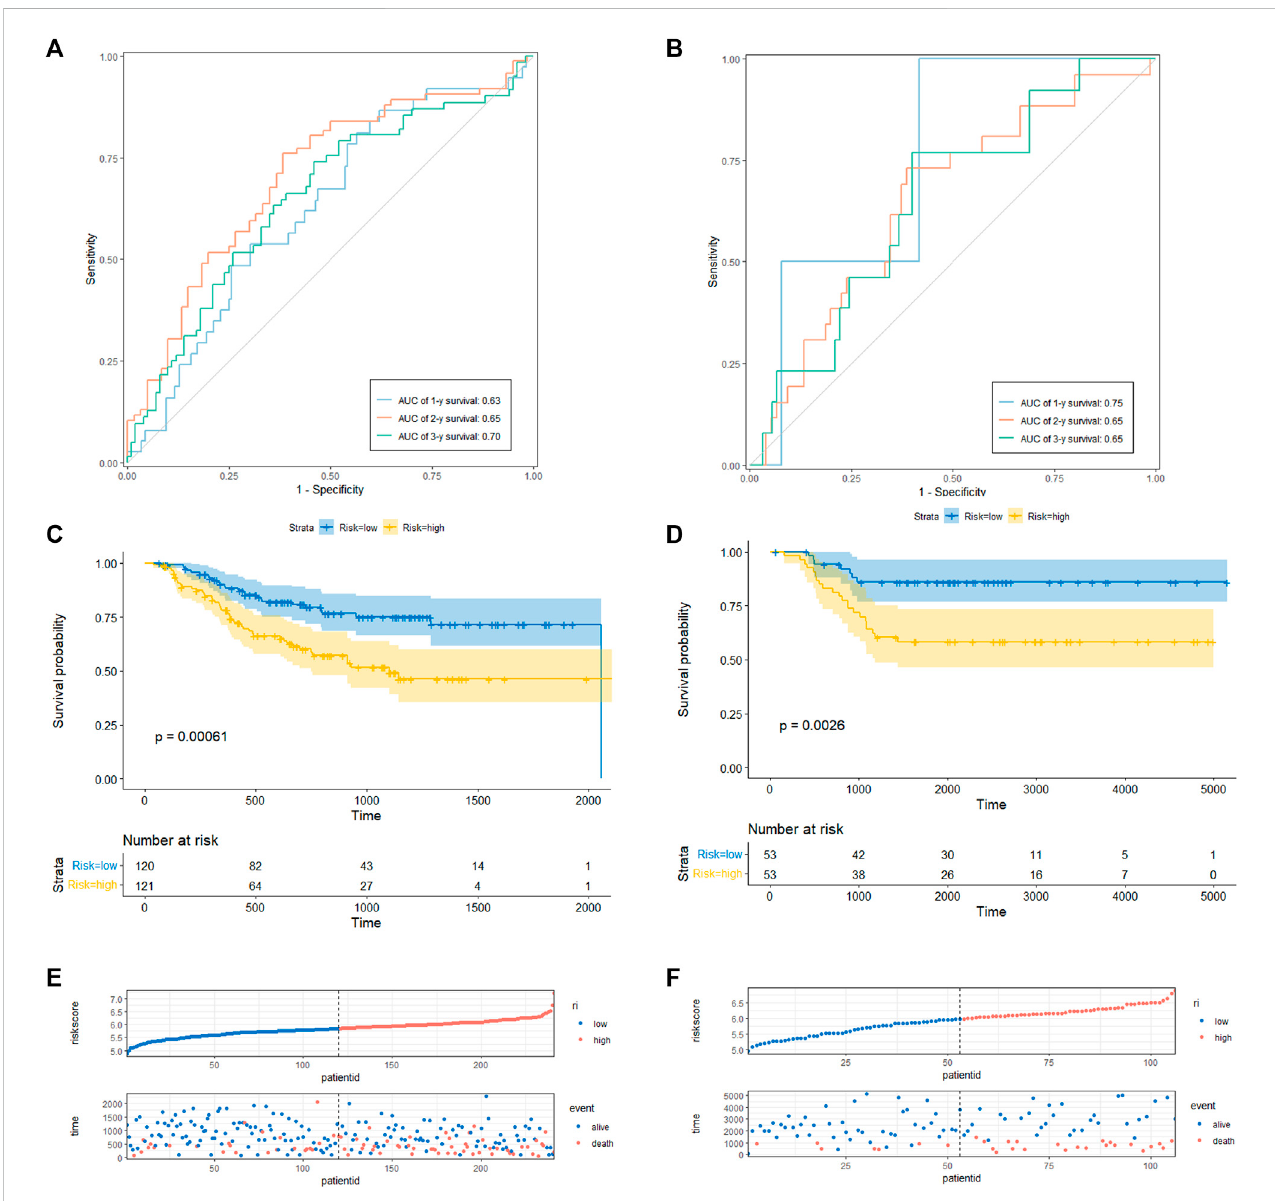
FIGURE 4 CRRGs signature associated with BC patient ’ s disease-free survival (DFS) and metastasis-free survival (MFS). (A) The predictive value for the 1-y, 2-y and 3-y DFS in GSE21653 dataset. (B) The predictive value for the 1-y, 2-y and 3-y MFS in GSE58812 dataset. (C) The DFS between the CRRGs high- and low-risk groups in GSE21653 dataset. (D) The MFS between the CRRGs high- and low-risk groups in GSE58812 dataset. (E) The risk plot of the CRRGs signature in GSE21653 dataset. (F) The risk plot of the CRRGs signature in GSE58812